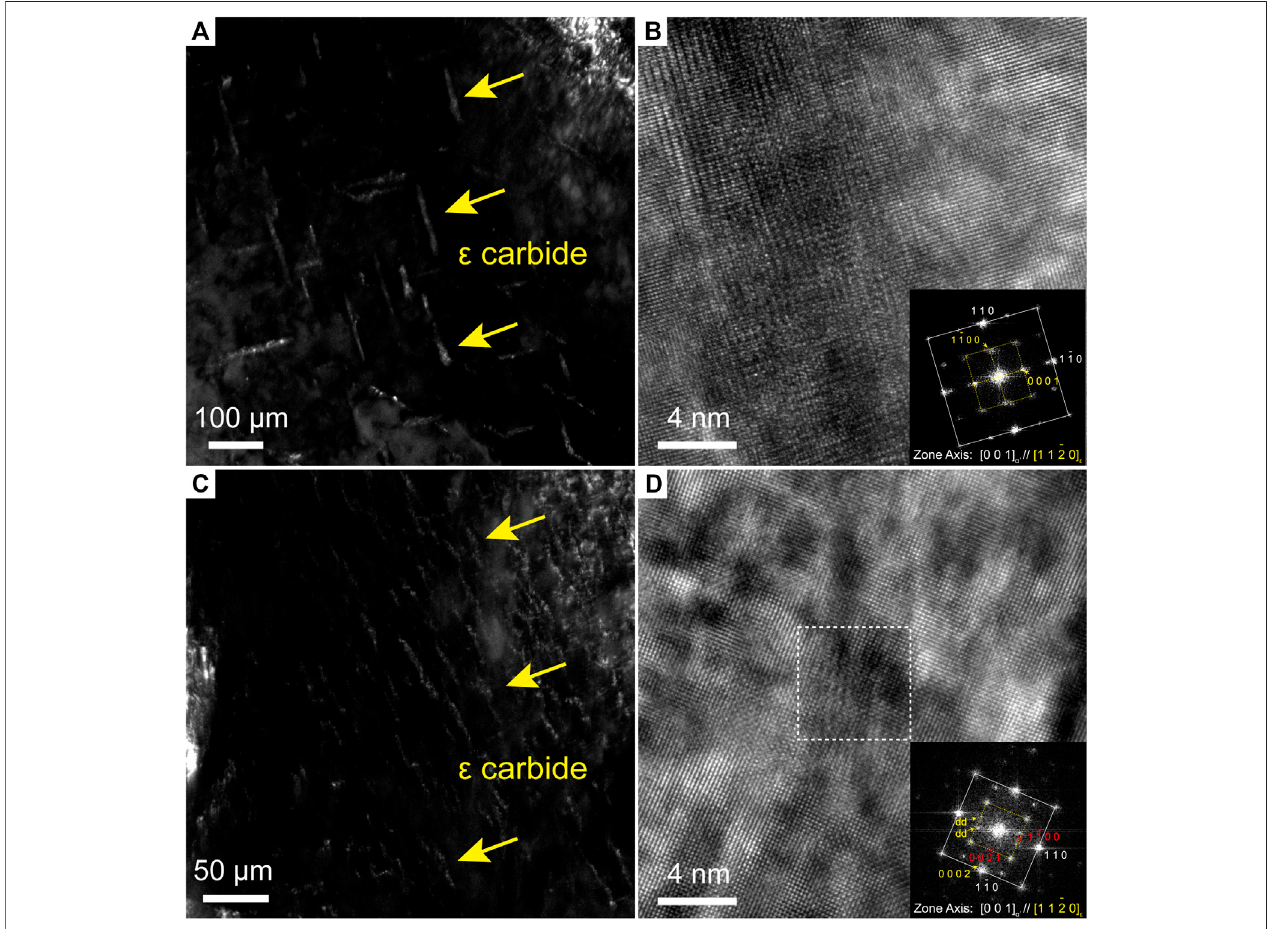
FIGURE 5 | TEM dark- fi eld micrographs showing the distribution of ε carbides in (A) 22MnB5 steel and (C) 34MnB5V steel; HRTEM images of ε carbide and the corresponding FFT diffractograms in (B) 22MnB5 steel and (D) 34MnB5V steel.